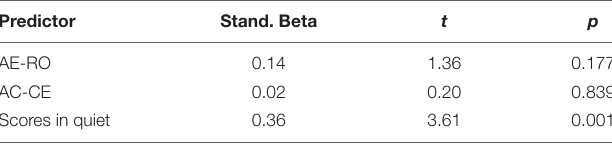
TABLE 5 | Beta-weights of AE-RO, AC-CE and comprehension scores in quiet as the predictors of English listening comprehension in white noise. Predictor Stand. Beta